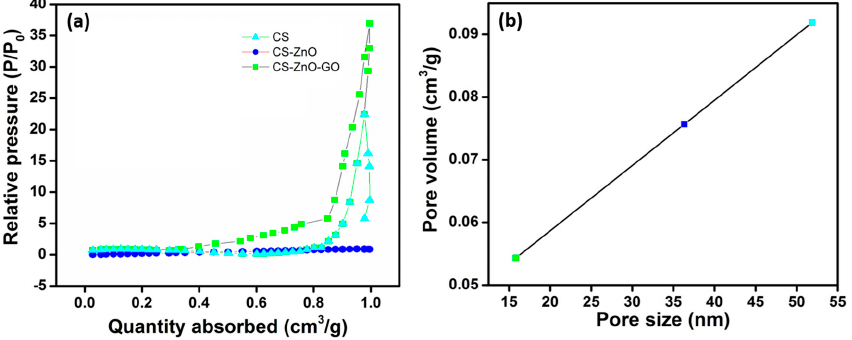
Figure 6. ( a ) Nitrogen adsorption–desorption isotherms and ( b ) pore volume versus pore size distribution of CS and the CS–ZnO and CS–ZnO–GO hybrid structures.